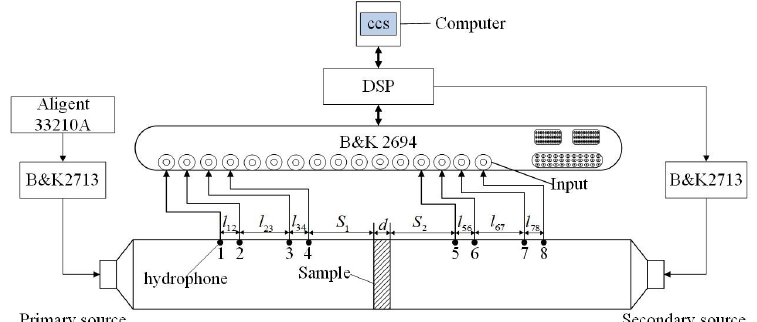
Figure 14. Experimental instrument connection diagram.